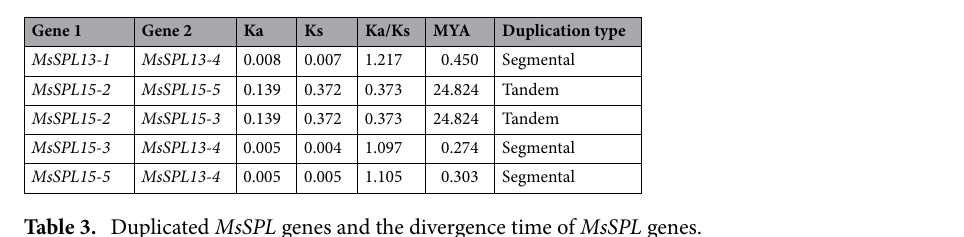
Table 3. Duplicated MsSPL genes and the divergence time of MsSPL